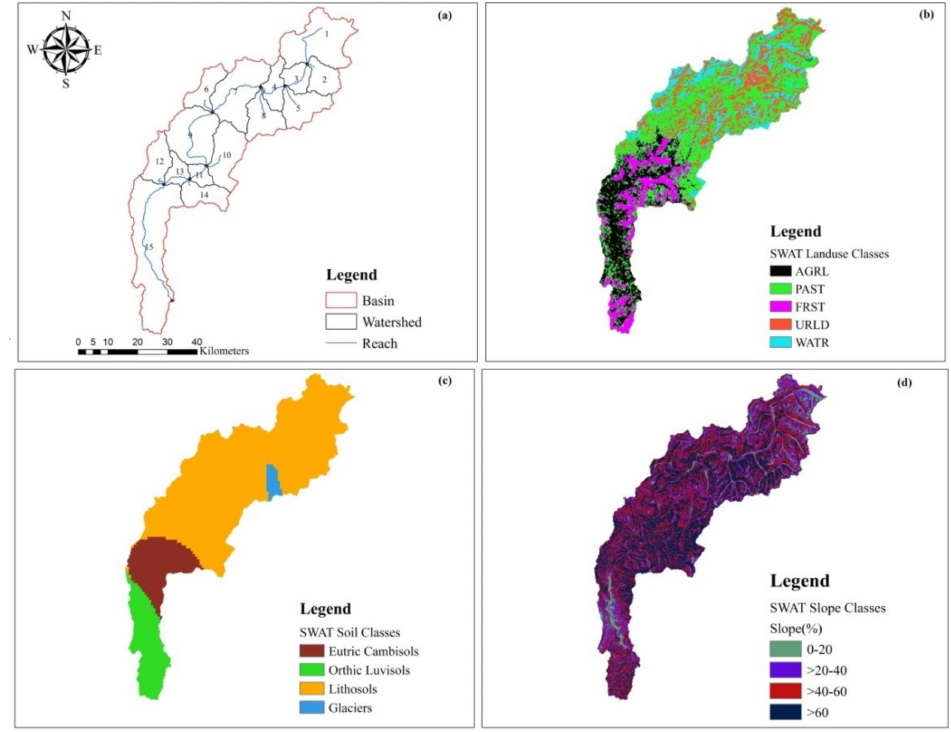
Figure 5. ( a ) Sub-basins; ( b ) Land-use classification; ( c ) Soil classification and ( d ) Slope classification of the KRB in the Arc SWAT